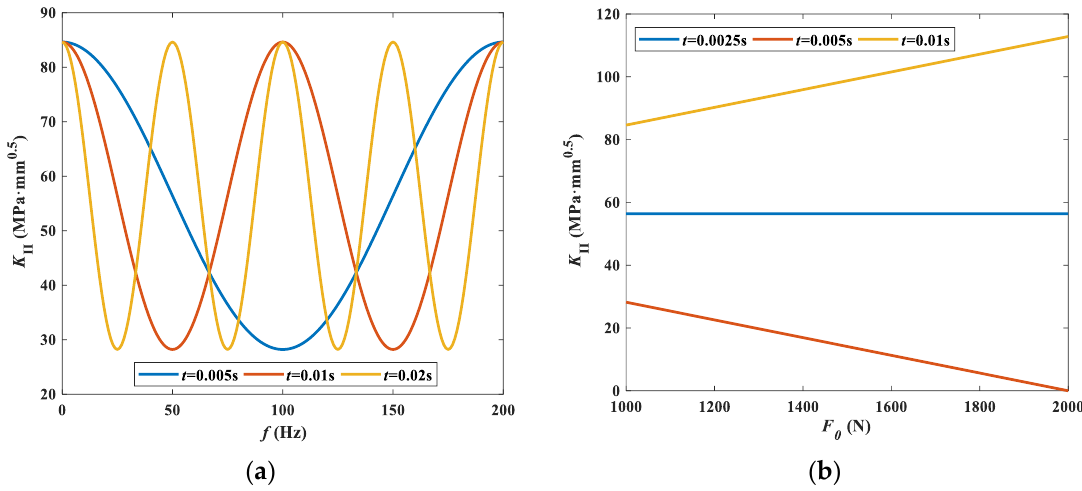
Figure 5. Variation of stress intensity factor with harmonic dynamic load at different moments: ( a ) dynamic load frequency; ( b ) dynamic load amplitude.